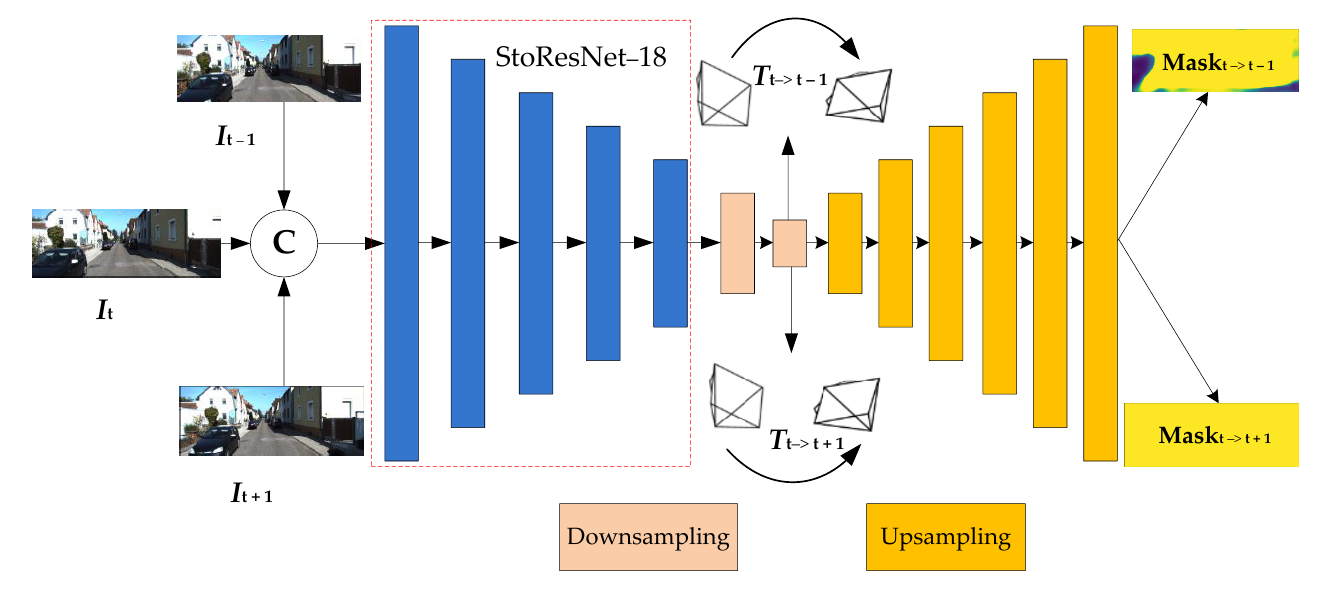
Figure 9. Pose and mask estimation network. The proposed method takes several adjacent frames as input and outputs the relative pose and mask, and the downsampling and upsampling structures are the same as those in Figure 5.